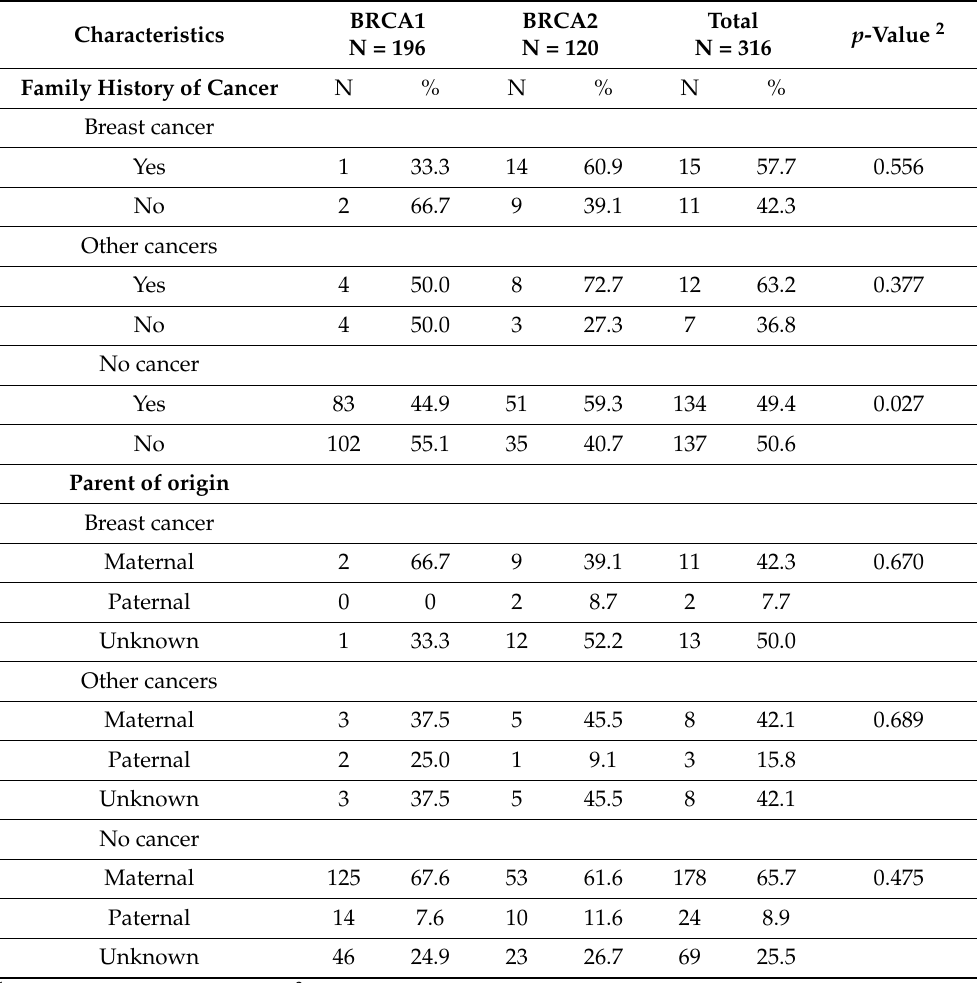
Table 5. Family history of cancer and parent of origin by first primary cancer and mutation type 1 .